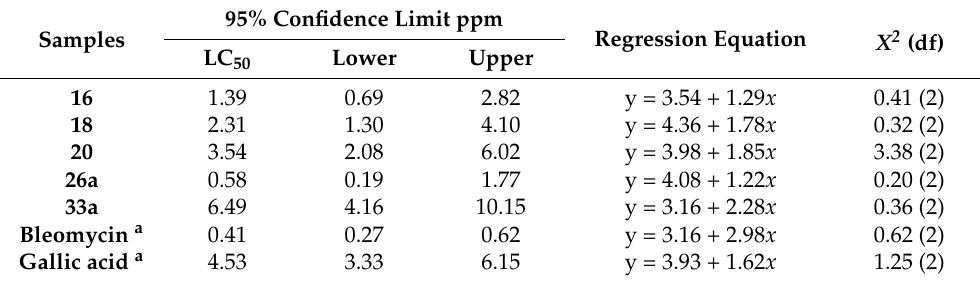
Table 3. Cytotoxicity activity of the synthesized compounds 16 , 18 , 20 , 26a and 33a . Samples